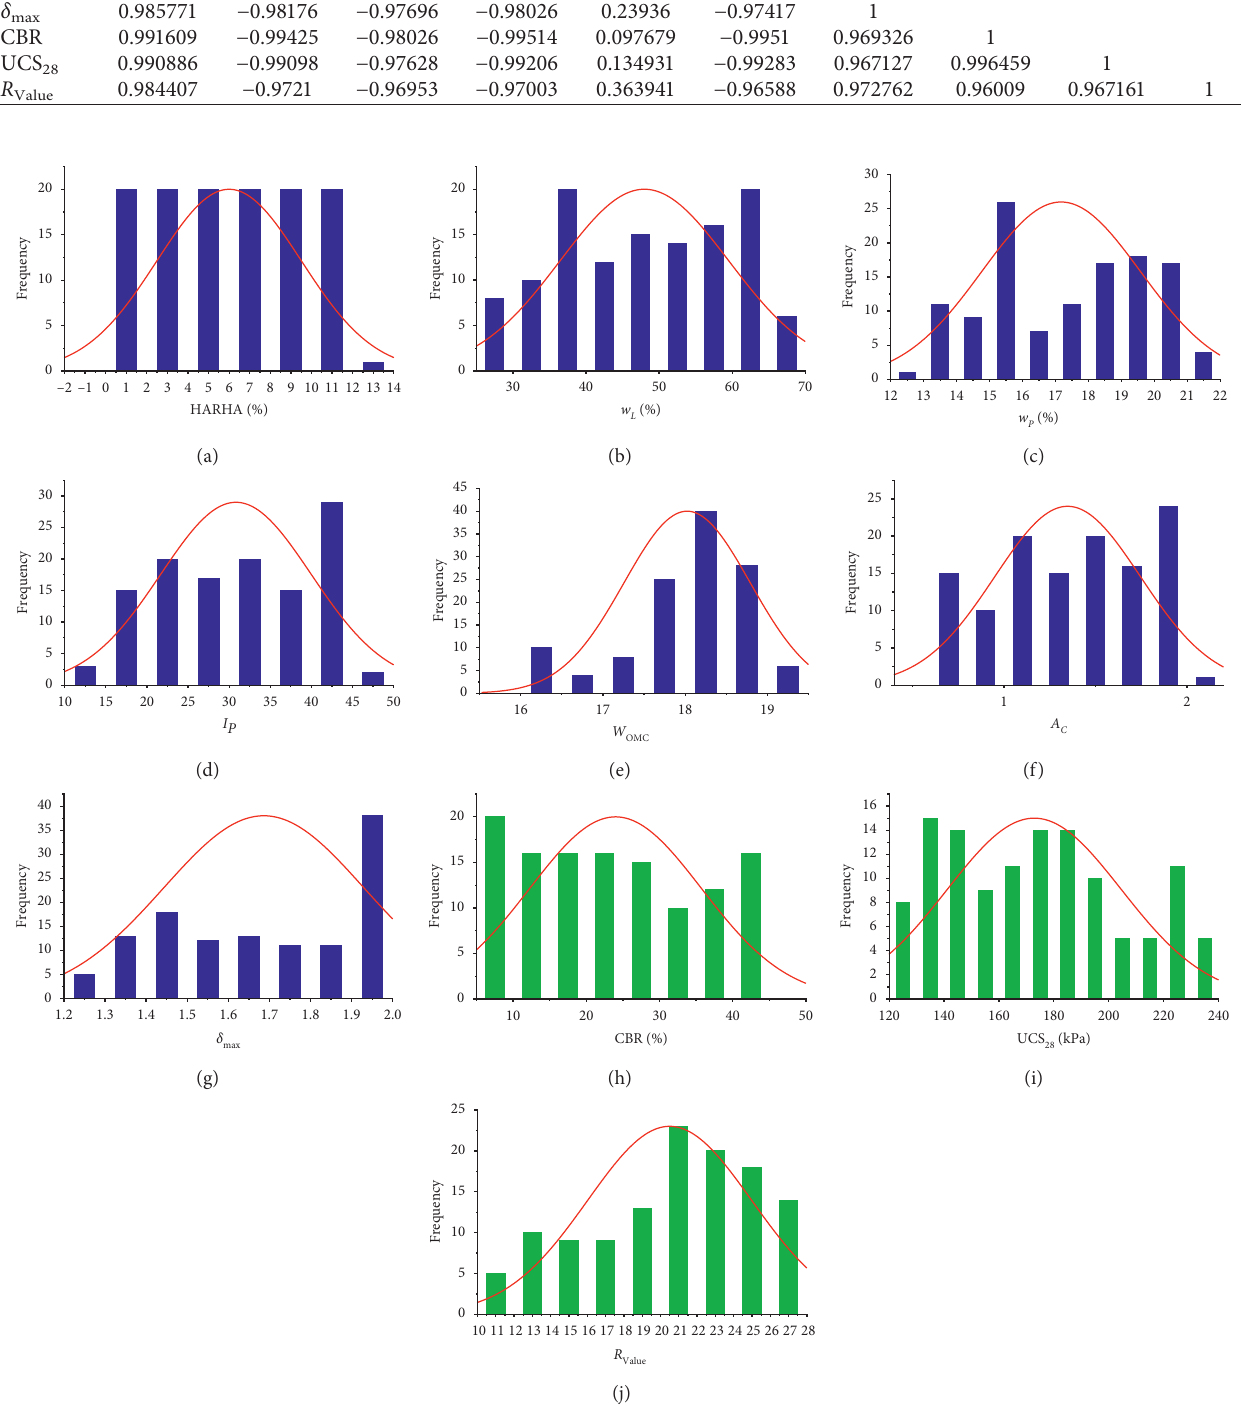
Figure 3: Frequency histograms of the input and output variables: (a) HARHA; (b) w UCS 28 ; (j) R Value . Note: the input parameters are illustrated in blue while the output variables are expressed as green